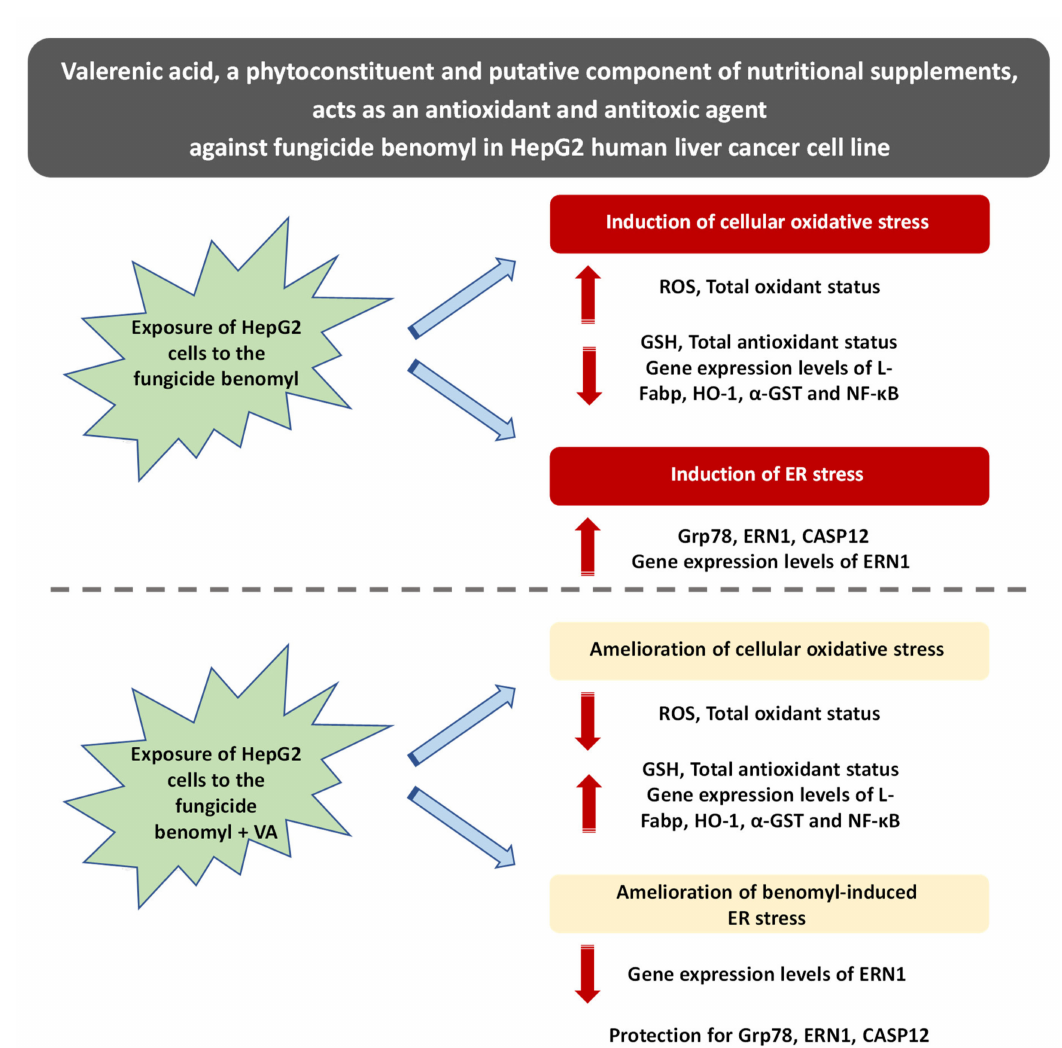
Figure 8. A graphical illustration of the main findings reported in the present study, according to which VA, a phytocon- stituent that exerts ameliorative effects against oxidative stress induced by the fungicide benomyl at the cellular and ER levels in HepG2 cells. VA: valerenic acid; ER: endoplasmic reticulum; GSH: reduced form of glutathione; ROS: reactive oxygen species; L-Fabp: liver-type fatty acid-binding protein; HO-1: heme oxgenase-1; a-GST: a-glutathione-S transferase; NF- κ B: nu-clear factor kappa-light-chain-enhancer of activated B cells; Grp78: human glucose-regulated protein 78; ERN1: human endoplasmic reticulum to nucleus signaling 1; CASP12: caspase